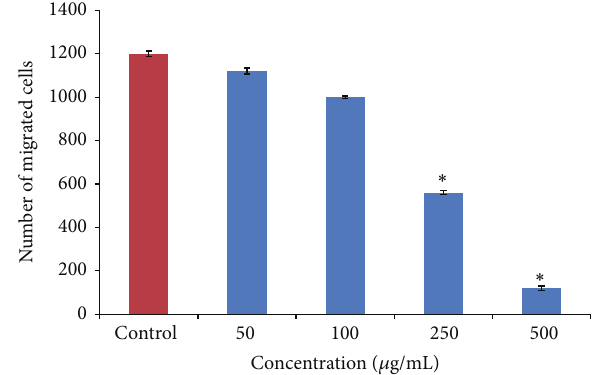
Figure 2: The number of migrated cells per three random fields was counted using an inverted microscope (Nikon ECLIPSE TI-S) at 400x magnification. Data are expressed as means ± SD, 𝑛 = 3 . Student’s paired 𝑡 -test showed significant values, ∗ 𝑃 < 0.05 versus control.